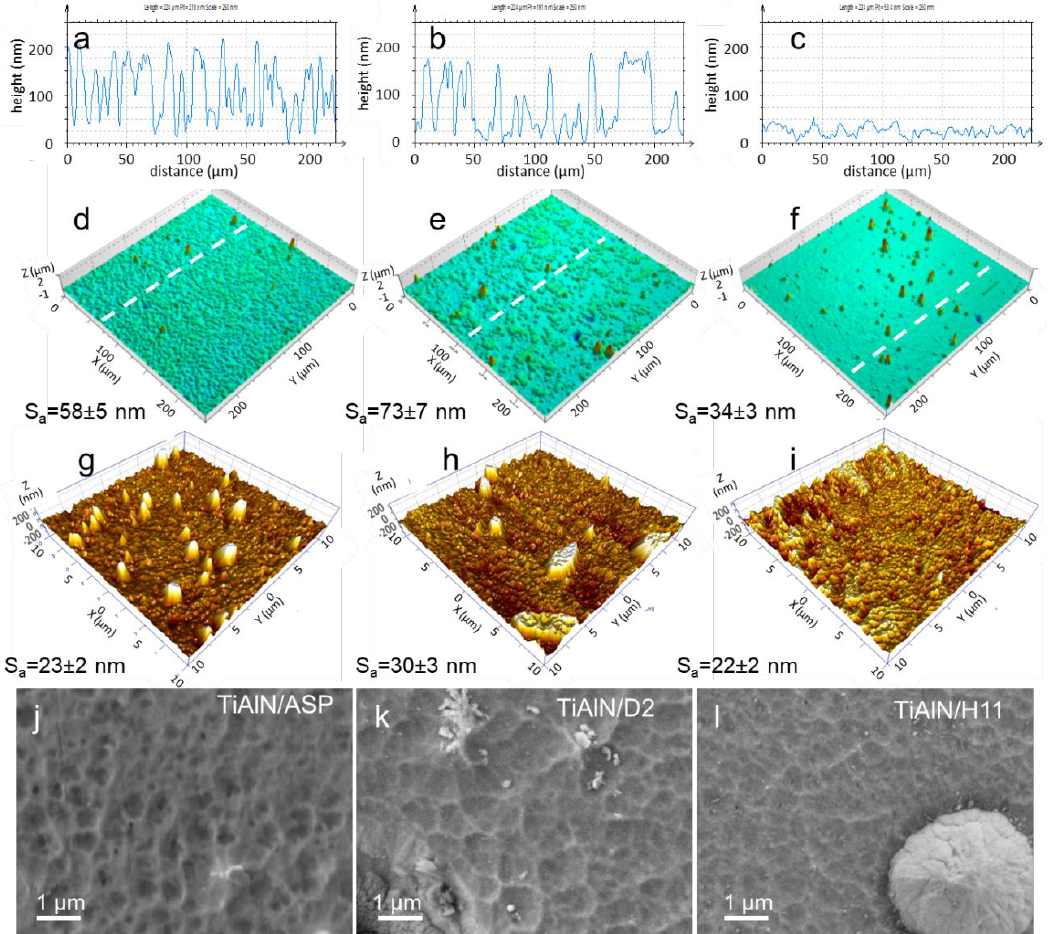
Figure 24. The 3D surface profile images ( d – f ), AFM images ( g – i ) and top-view and SEM ( j – l ) images of TiAlN hard coating sputter deposited in CC7 system on three different tool steel substrates (ASP30, D2, H11). The sharp peaks in 3D surface profile images are the nodular defects while the blue dots are craters. The line profiles ( a – c ) were recorded on the defect-free areas of 3D profile images ( d – f ).